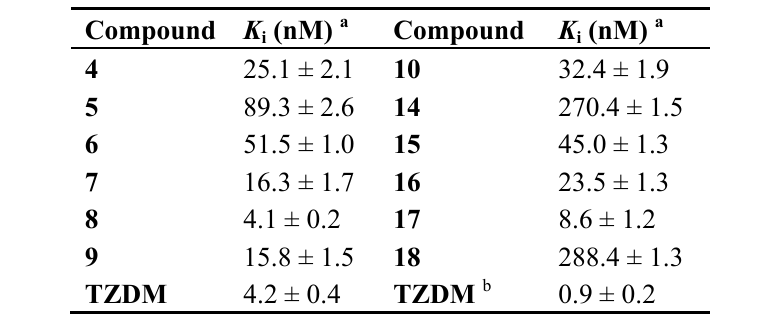
Table 1. K values of ( E )-5-styryl-1 H -indole and ( E )-6-styrylquinoline derivatives for A β i aggregates against [ 125 I]TZDM.